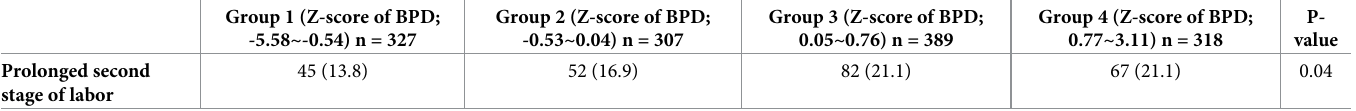
Table 4. Prevalence of prolonged second stage of labor according to Z-score of fetal biparietal diameter quartiles measured within 7 days before delivery in nullipa- rous women. Group 1 (Z-score of BPD; -5.58~-0.54) n = 327